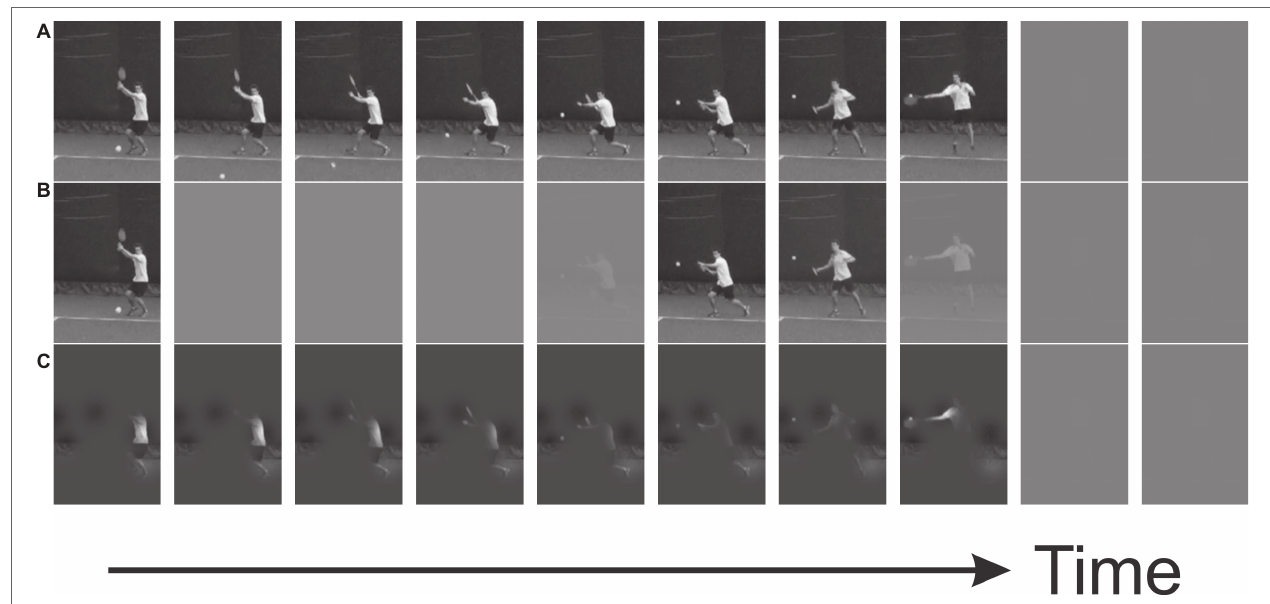
FIGURE 1 | Example stimuli, shown as snapshots from video every 100 ms. (A) Video occluded at point of racket-ball contact but with no bubbles manipulation (equivalent to pretest trials here). (B) Temporal bubbles permit viewing of entire image, but only at certain times. (C) Spatial bubbles permit viewing of only certain regions of the image, but across all (precontact)